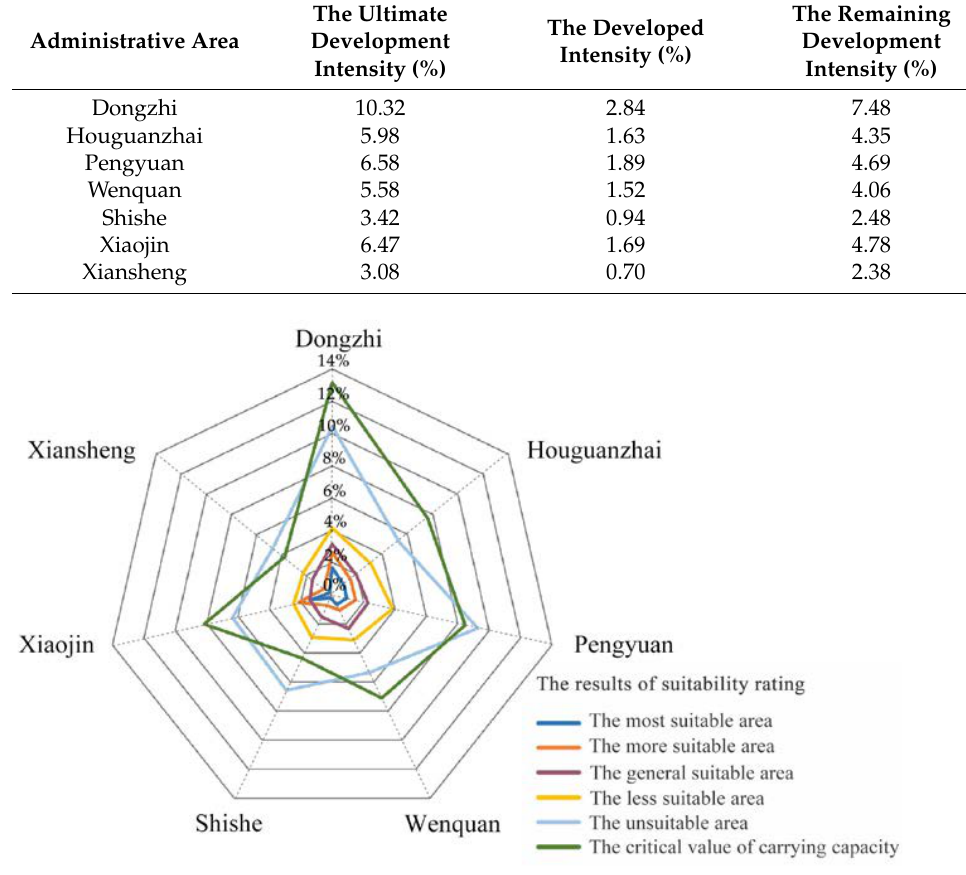
Table 3. The development intensity of townships construction land in Xifeng.